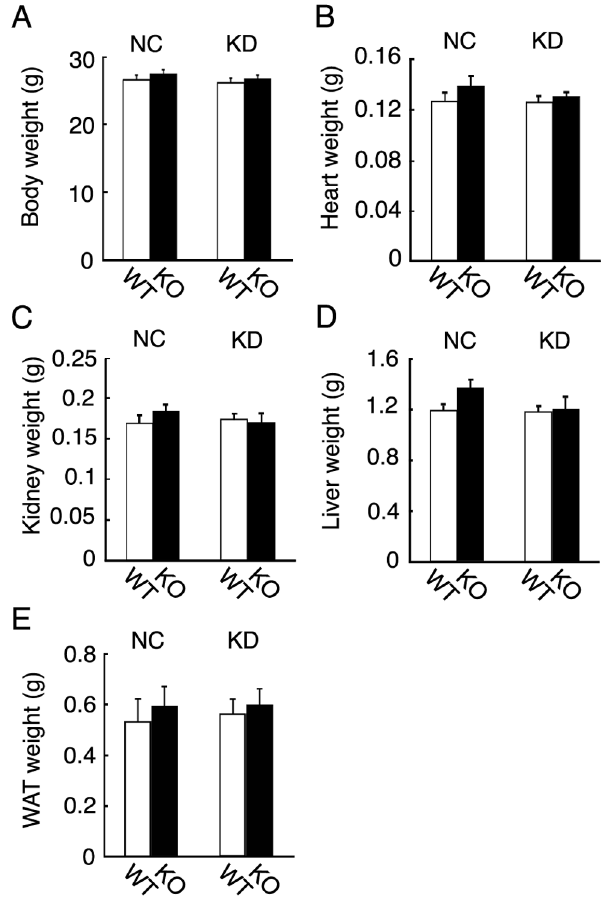
Figure 4. Body and tissue weights of wild-type and Fgf21 knockout mice fed NC or KD. (A) Body weights of 3-month-old wild- type (WT) and Fgf21 knockout (KO) mice fed NC or KD for 6 days (n=7– 8 mice per group). (B–E) The heart, kidney, liver, and subcutaneous WAT weights of 3-month-old wild-type (WT) and Fgf21 knockout (KO) mice fed NC or KD for 6 days (n=7–8 mice per group).